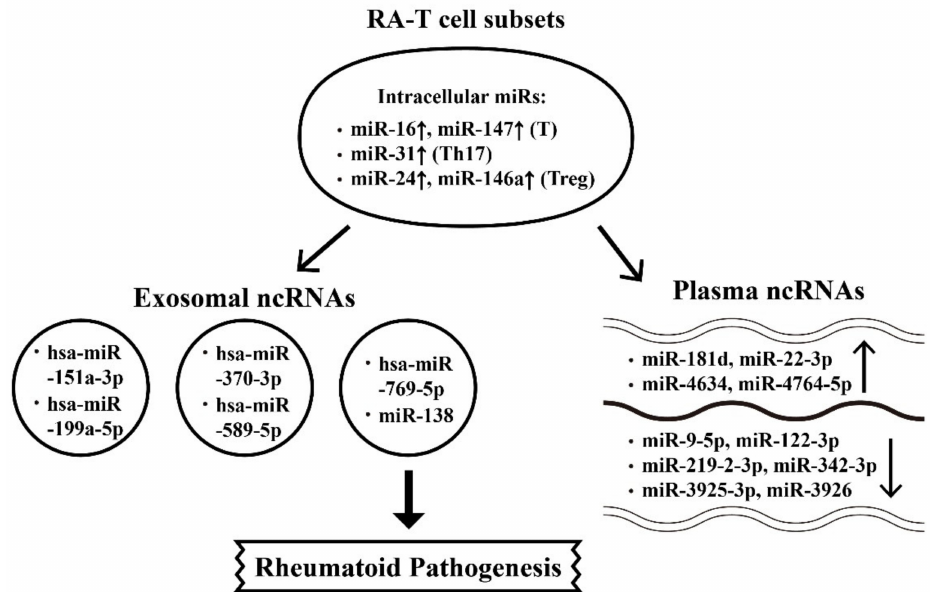
Figure 4. The involvement of intracellular microRNAs (miRs) in the T cell differentiation and T cell release of exosomal and plasma miRs during the development of rheumatoid arthritis (RA). The T cell subpopulations include the total CD4 + T, Th17, and regulatory T cell. ↑ : Increase, ↓ :